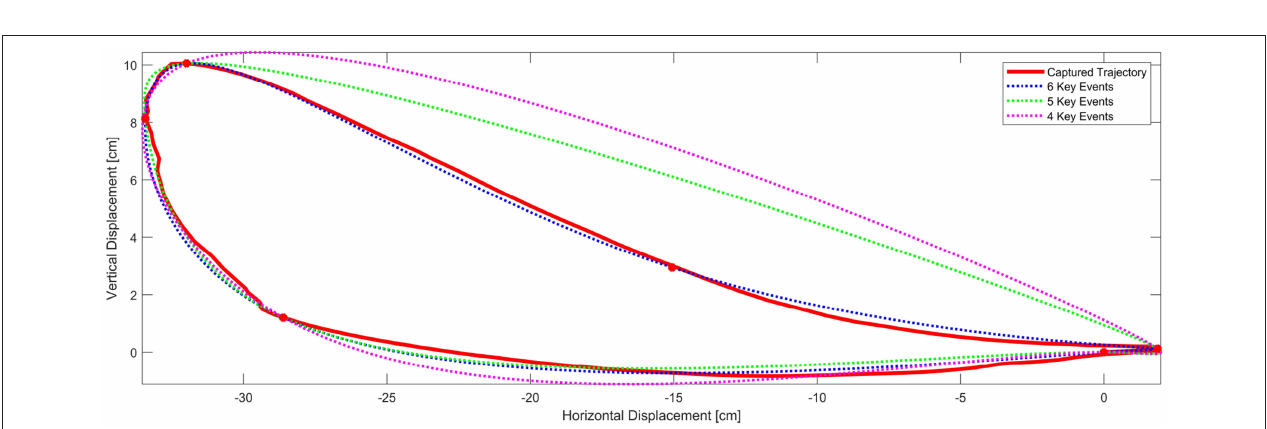
FIGURE 4 | Comparison between using 4, 5 or 6 key events for the trajectory generator. Fidelity measures are: 72.4%, 81.7%, and 97.3%, respectively, thereby suggesting that the trajectory generator method should incorporate 6 key events herein proposed.